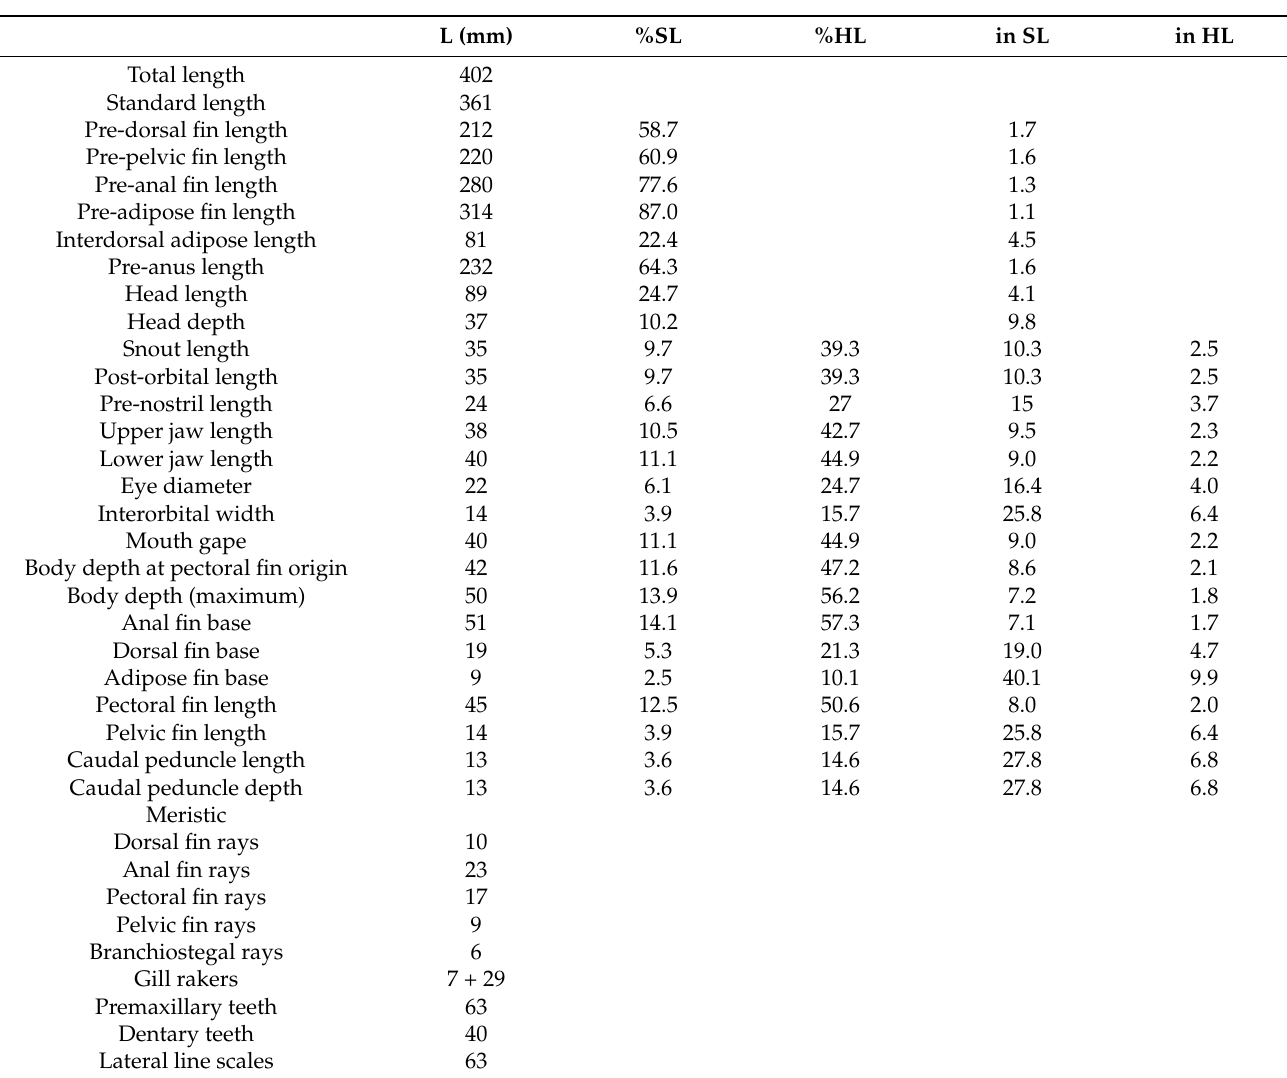
Table 1. Morphometric and meristic data of Magnisudis atlantica MHN USC